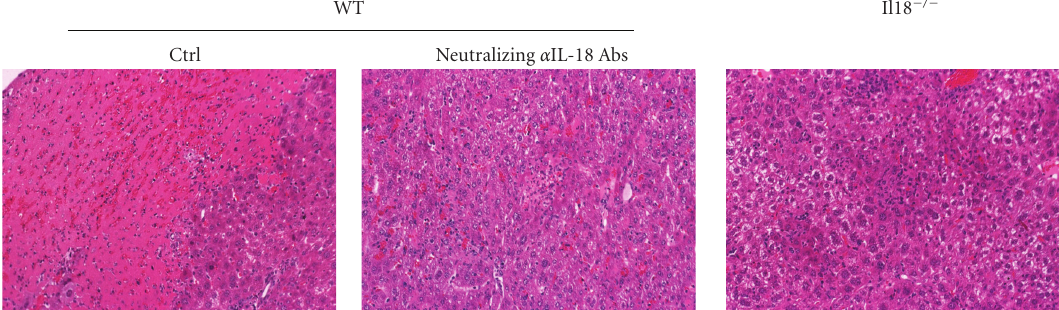
Figure 6: Importance of IL-18 for the development of P. acnes /LPS-induced liver injury. P. acnes -primed wild-type (WT) showed liver necrosis after LPS challenge. However, treatment with neutralizing anti-IL-18 just before LPS challenge could protect against this liver injuries [17]. Furthermore, Il 18 − / − mice were resistant to the sequential treatment with P. acnes and LPS [18]. Table 1: Clinical manifestations upon LPS challenge. Na¨ıve mice, P. acnes -primed mice, and P. acnes -primed mice depleted of macrophages (Mø) were challenged with LPS, and hypothermia, hypercoagulation, lethality and liver injuries were monitored by measurement of rectal temperature a , measurement of plasma TAT/PAI-1 levels b and histological analyses d . Systemic alterations Liver injury d Mice Hypothermia a Hypercoagulation b Lethality (%) c Na¨ıve − ± 0 −